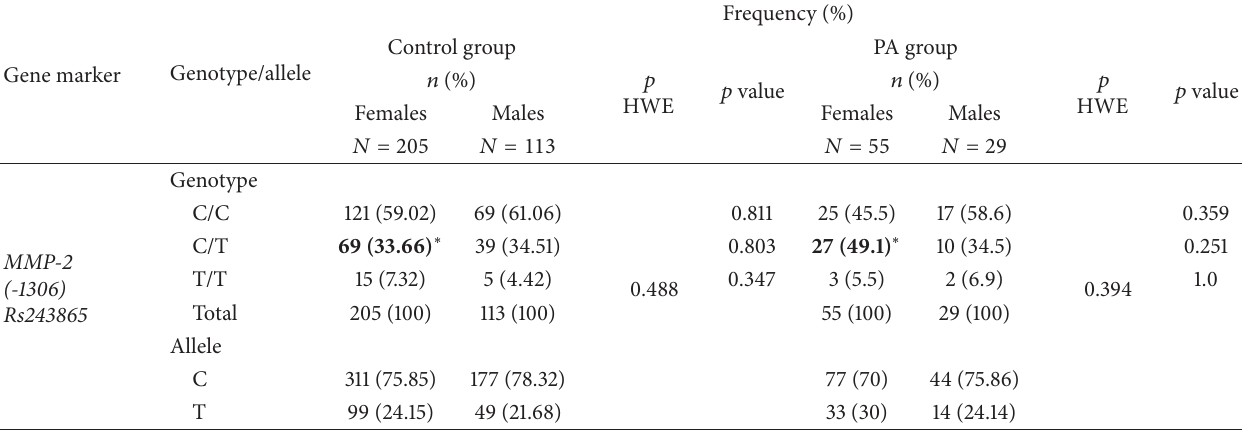
Table 3: Frequency of MMP-2 (-1306 C/T) genotype in the patients with pituitary adenoma (PA) and in the control group by gender.